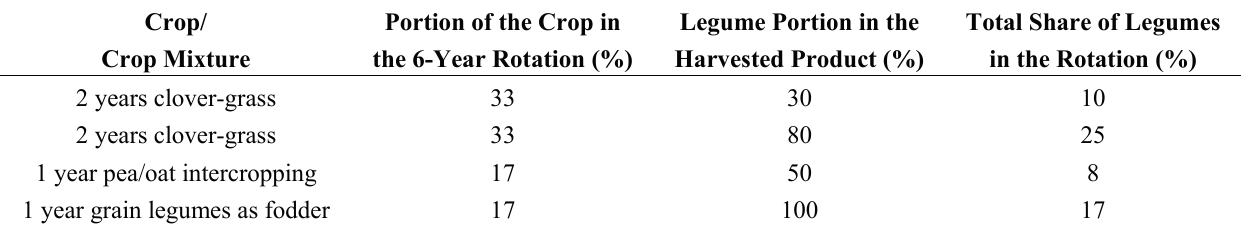
Table 2. Calculation of the amount of legumes in a 6 year crop rotation. Crop/